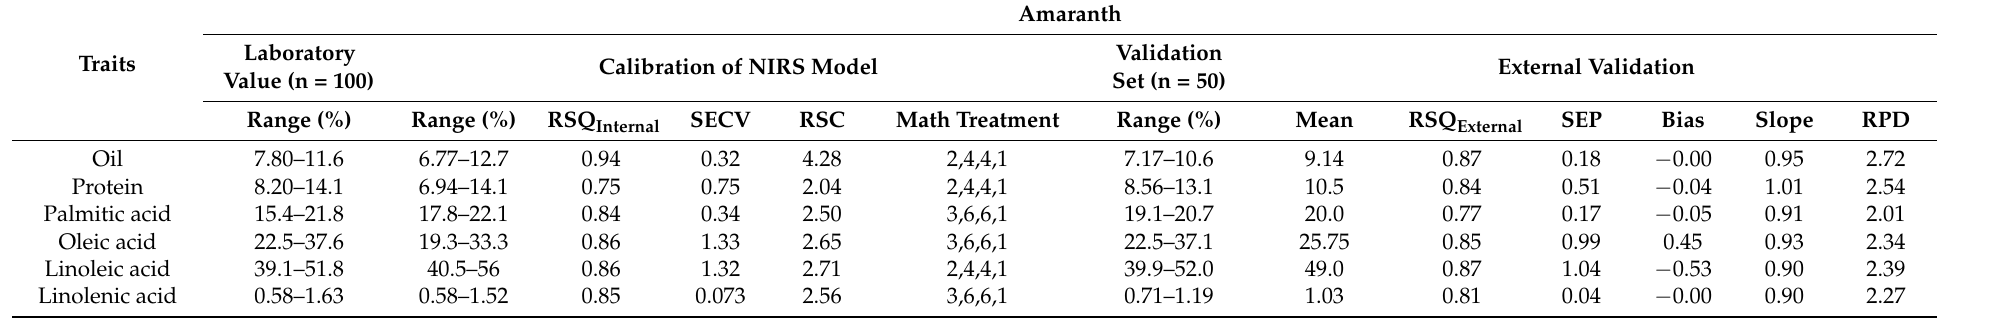
Table 1. Statistics for different traits of amaranth used in calibration and validation.